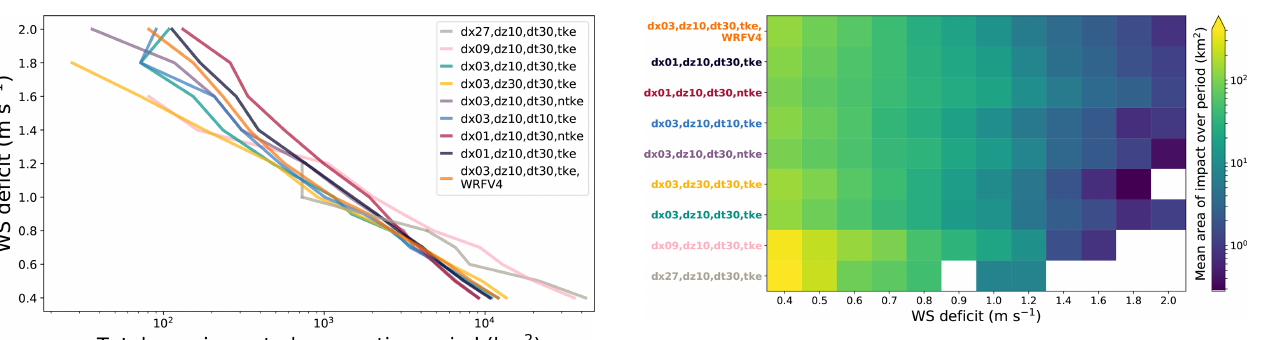
and fails to capture higher-magnitude temperature increases. Occasional instances of cooling occur typically just before sunset and are exaggerated in coarser-horizontal-resolution configurations, likely caused by convection in the daytime with locations shifted due to the presence of the wind